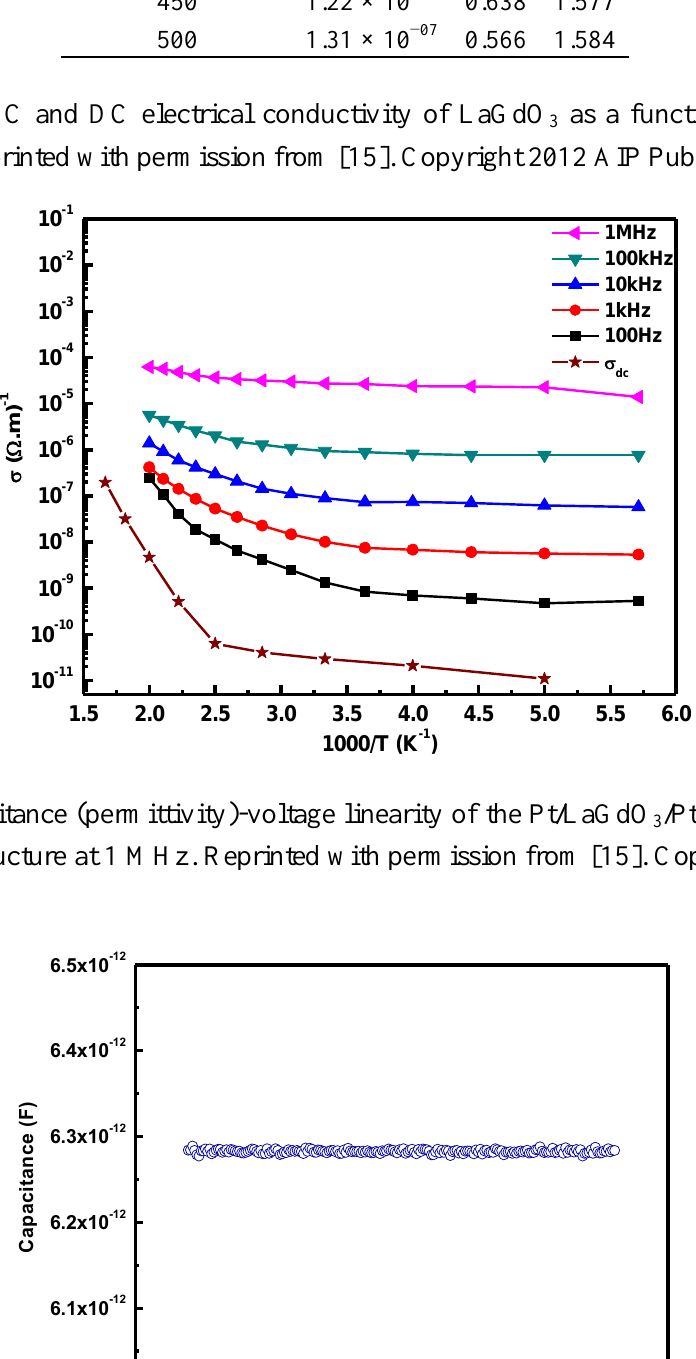
as a function of reciprocal 3